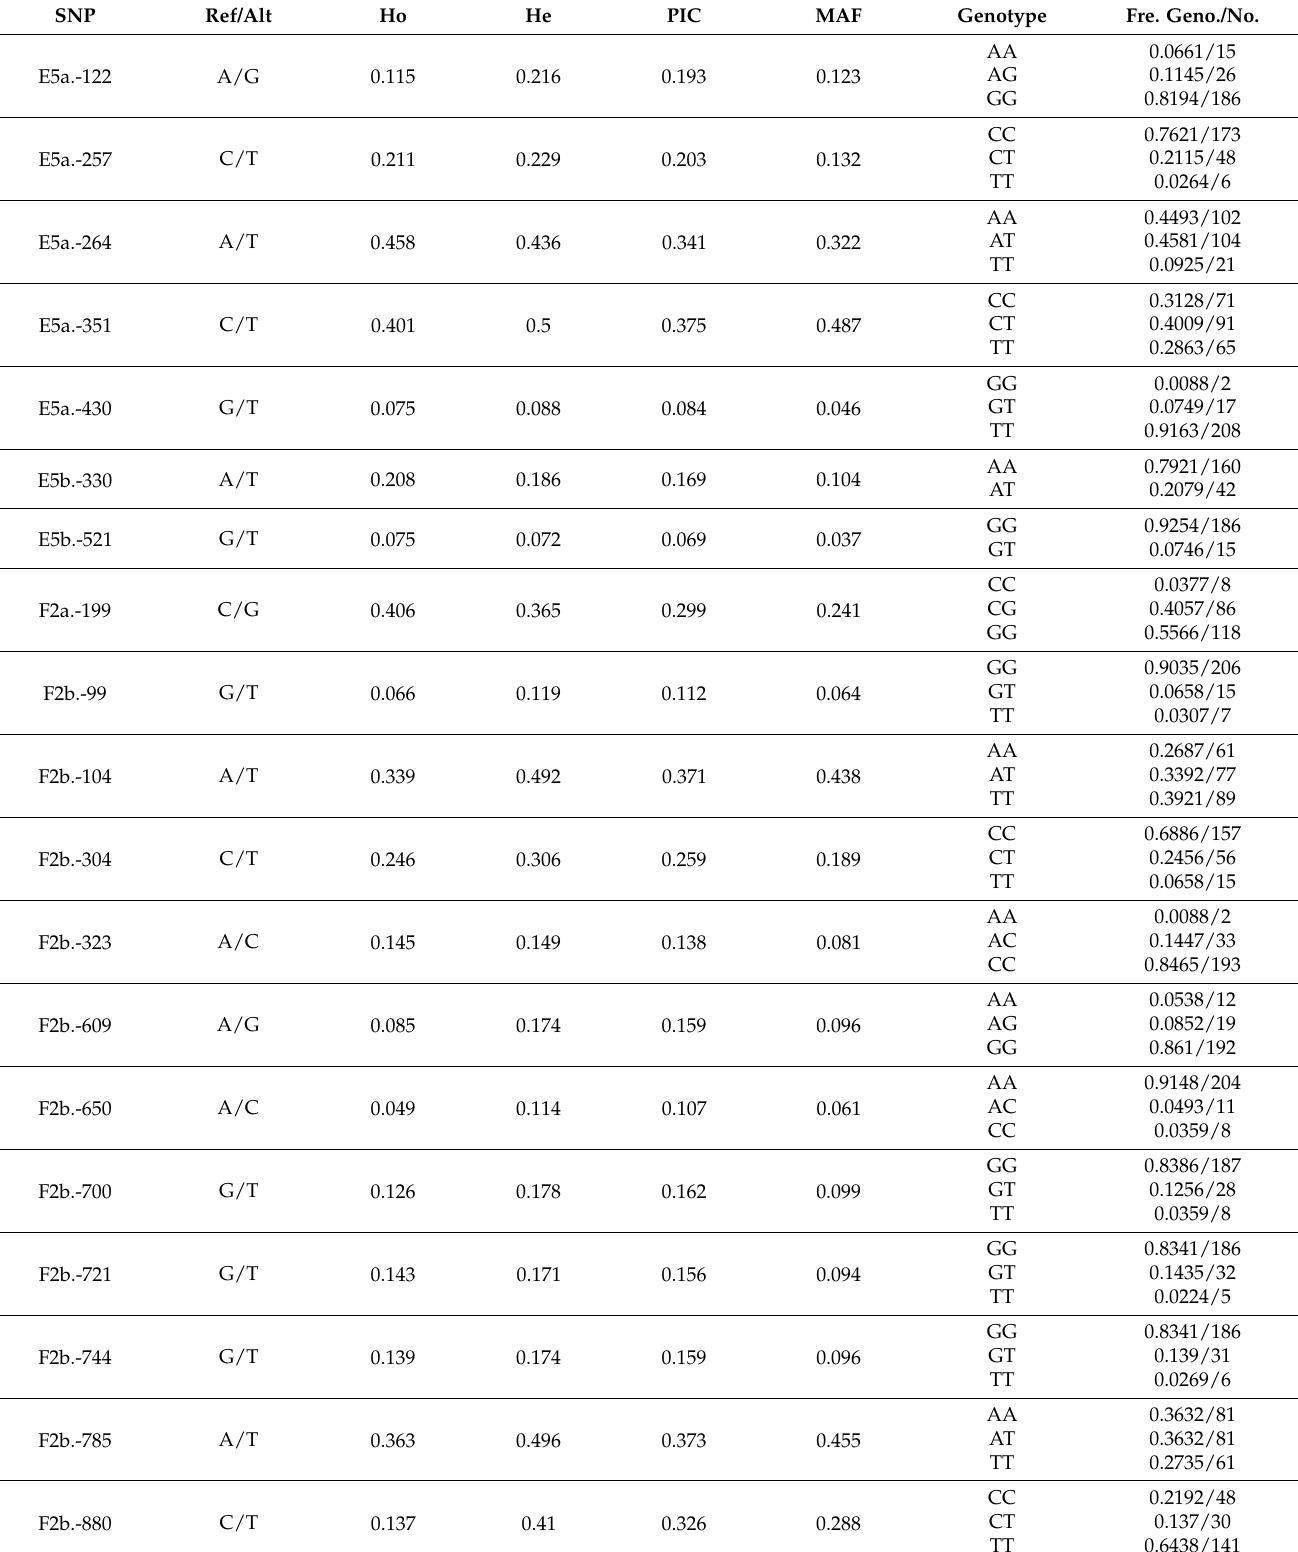
Table 1. Genetic diversities of the promoters of elovl5a , elovl5b , fads2a , and fads2b